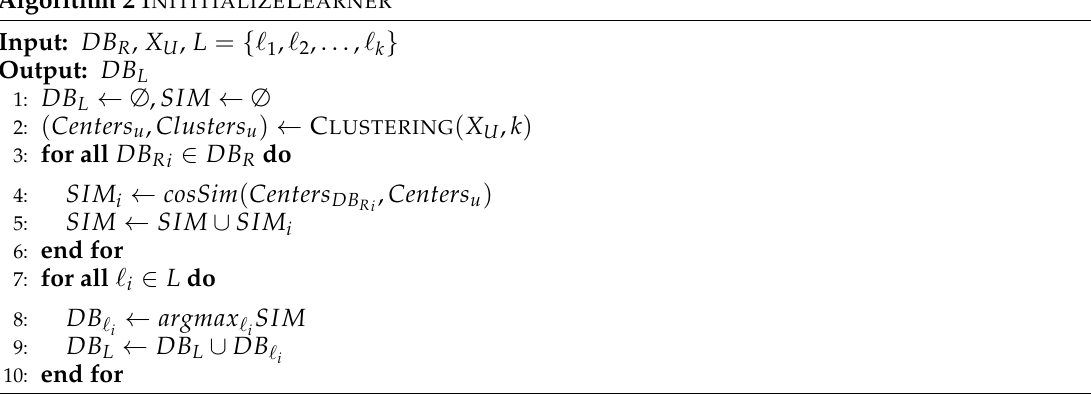
Algorithm 2 I NITITIALIZE L EARNER